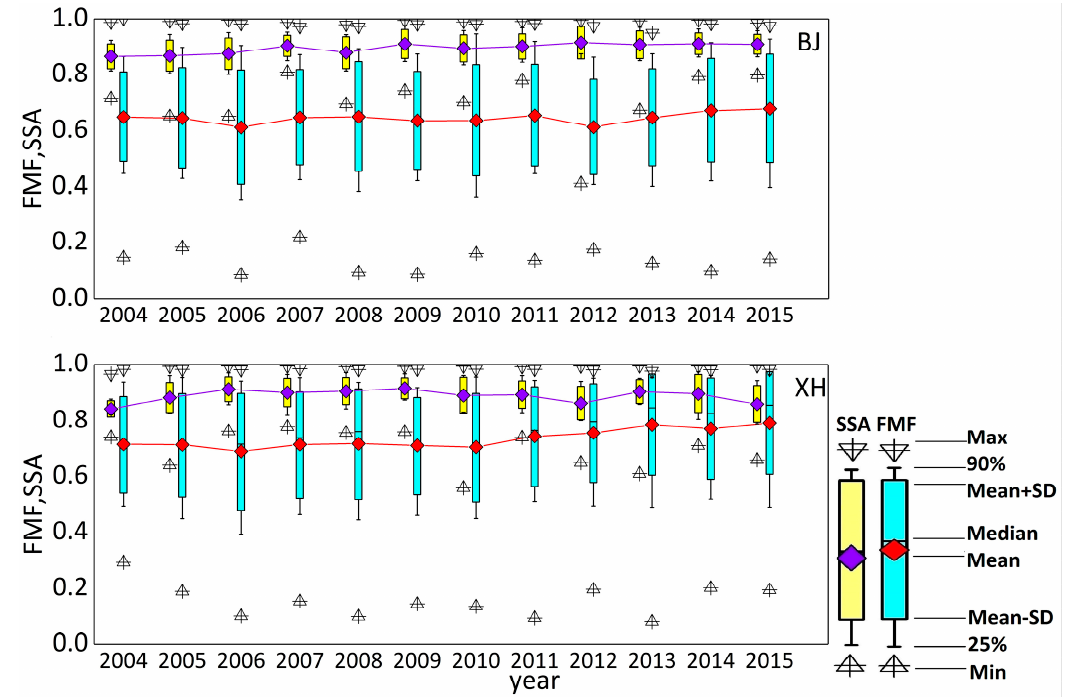
Figure 4. Annual average variation characteristics of the optical properties in BJ and XH.